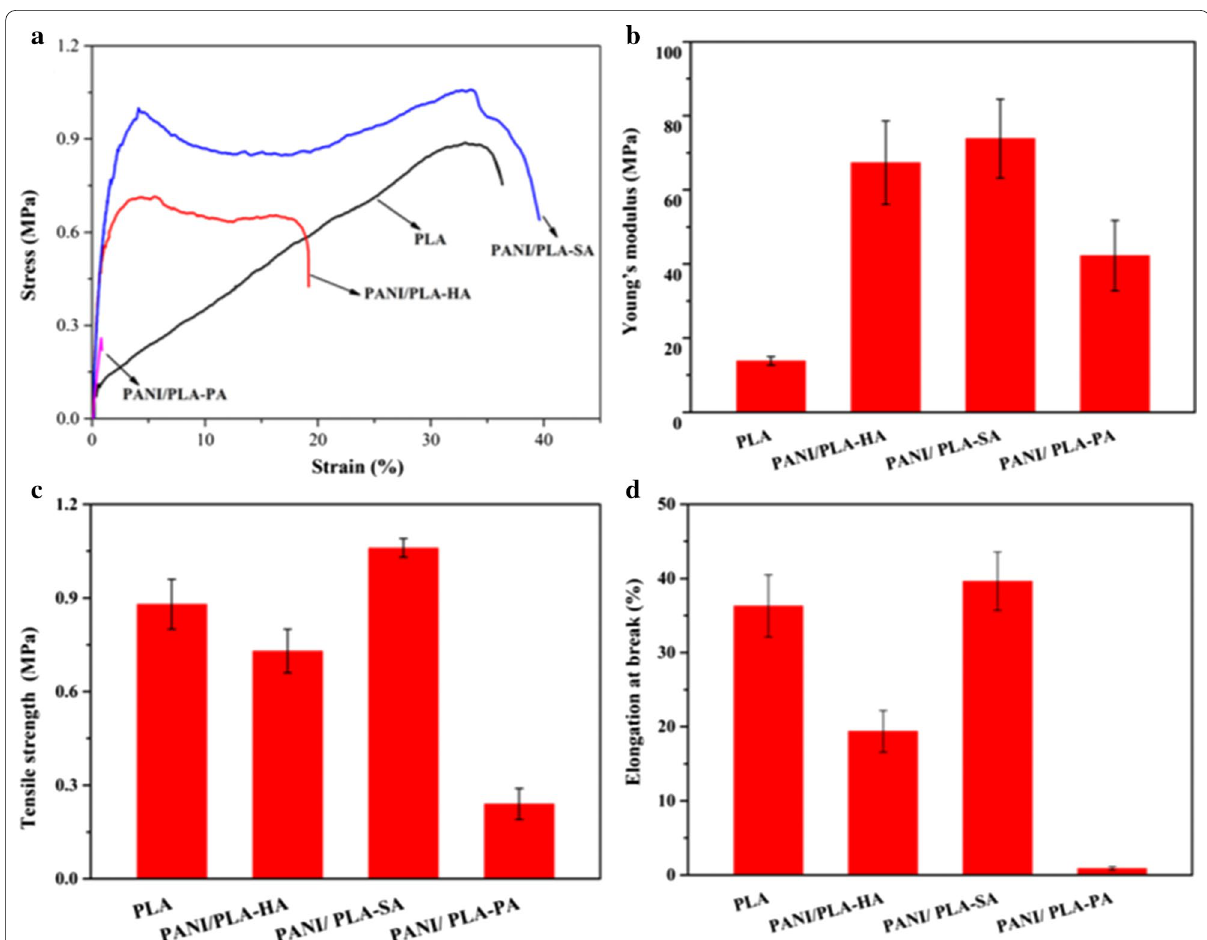
Fig. 2 Mechanical properties of PLA nanofibers and PANI/PLA composite nanofibers. a Representative tensile stress–strain curves, b Young’s modulus, c tensile strength at break, d elongation at